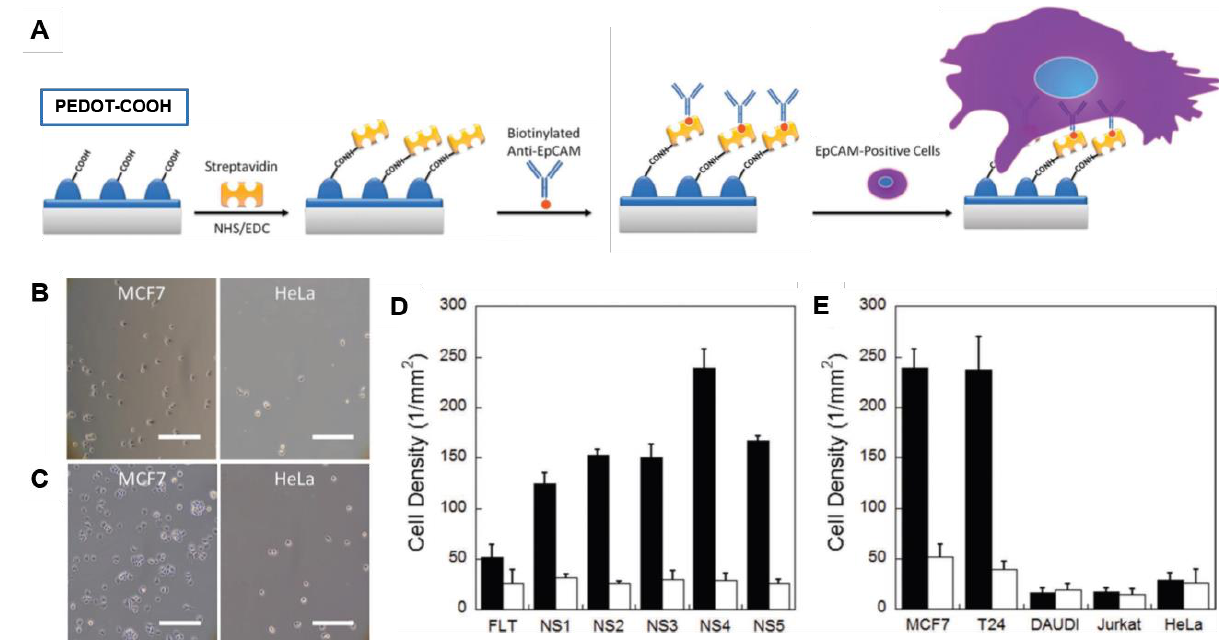
Figure 16. Scheme of the PEDOT-COOH functionalization process ( A ). MCF7 and HeLa cell capturing using flat anti-EpCAM conjugated PEDOT films (PEDOT-FLT) ( B ) and anti-EpCAM conjugated PEDOT nanodots (PEDOT-NS4) ( C ). MCF7 and HeLa cells capture yields for different anti-EpCAM conjugated PEDOT films ( D ). Synergistic effect of morphology and capture agents on cell capturing. Capture yields of various cell lines using anti-EpCAM conjugated PEDOT nanodots PEDOT-NS4 (black) and PEDOT films PEDOT-FLT (white). MCF7 and T24 cells are EpCAM-(+). DAUDI, Jurkat, and HeLa cells are EpCAM-(−) ( E ). Adapted with permission from reference [154]. Copyright 2011 John Wiley and Sons.